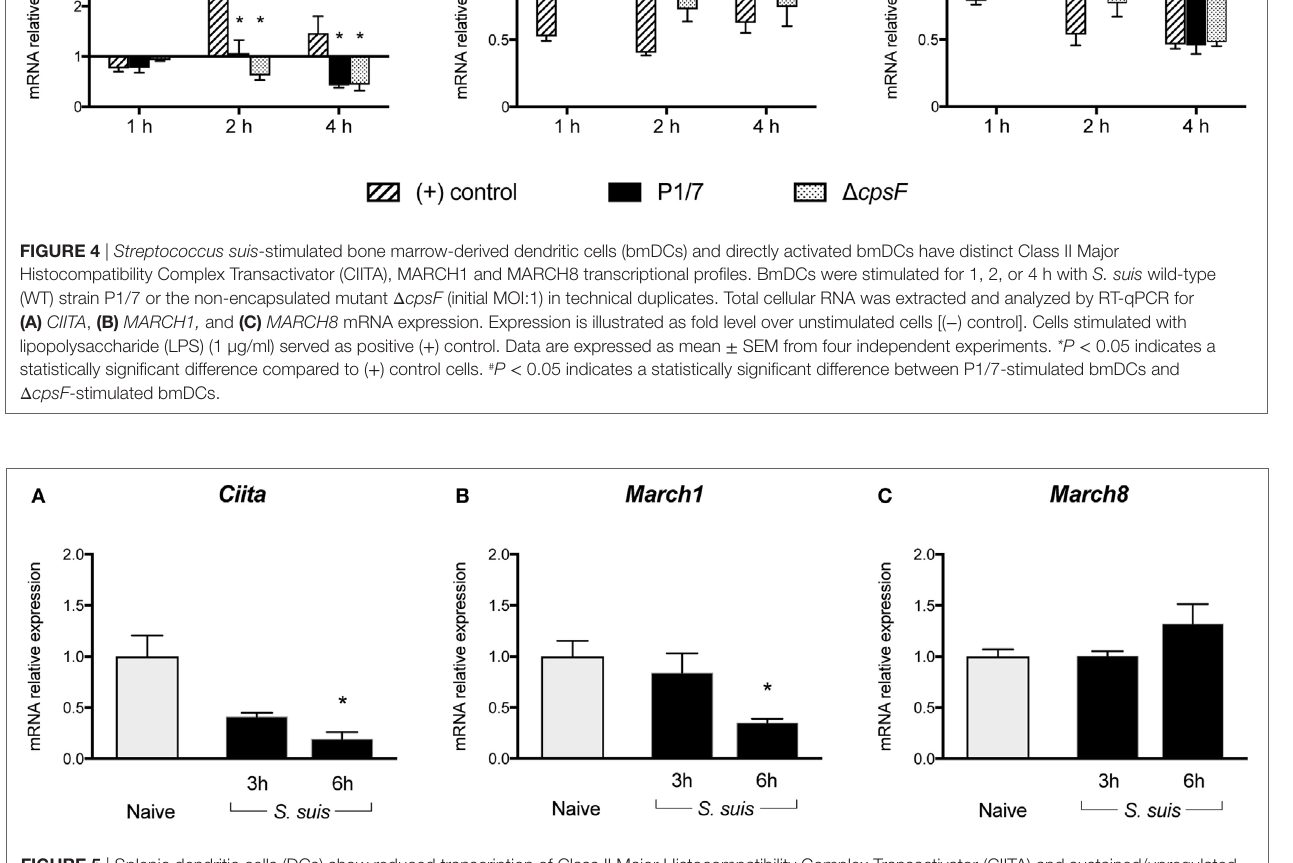
FigUre 5 | Splenic dendritic cells (DCs) show reduced transcription of Class II Major Histocompatibility Complex Transactivator (CIITA) and sustained/upregulated transcription of MARCH1 and MARCH8 during Streptococcus suis infection. C57BL/6 mice were injected intraperitoneally with 5 × 10 7 CFU of S. suis wild-type (WT) strain P1/7. Spleens from mock-infected (naïve) and infected mice were harvested 3 or 6 h after infection ( n = 2 to 3 per group × 2 independent experiments). Splenic DCs were purified by MACS positive selection, then total cellular RNA was extracted and analyzed by RT-qPCR for (a) CIITA , (B) MARCH1, and (c) MARCH8 mRNA expression. Expression is illustrated as fold level as compared to expression in naïve mice. Data are expressed as mean ± SEM. *P < 0.05 indicates a statistically significant difference compared to naïve cells.